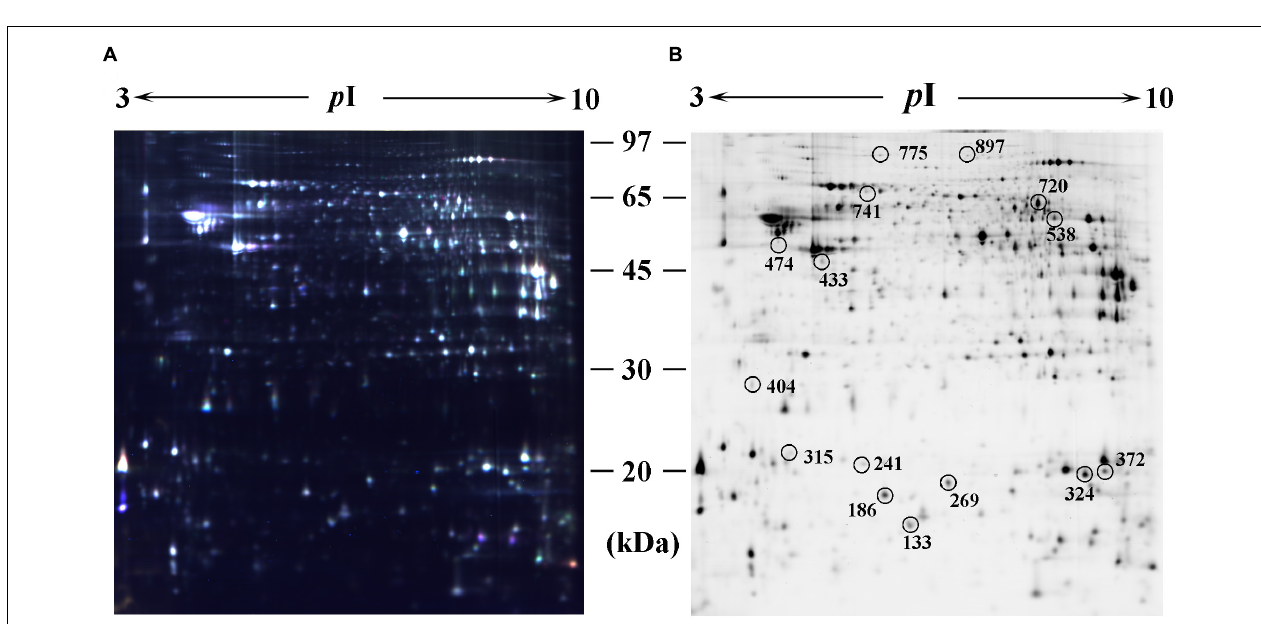
FIGURE 1 | CP deteriorated the spatial learning and memory deficits in APP/PS1 mice. The spatial learning and memory was assessed by the Morris water maze task. (A) Latency score represents the time taken to the platform once the mouse was put in the water. (B) Times across the platform represent the frequency for a mouse to swim across the circle where the hidden platform located previously. CP significantly deteriorated attenuated the learning and memory deficits as compared to control mice. Data represent mean ± SD. n =16 mice per group. ∗ p < 0.05 vs. control group. # p < 0.05 vs. control group.